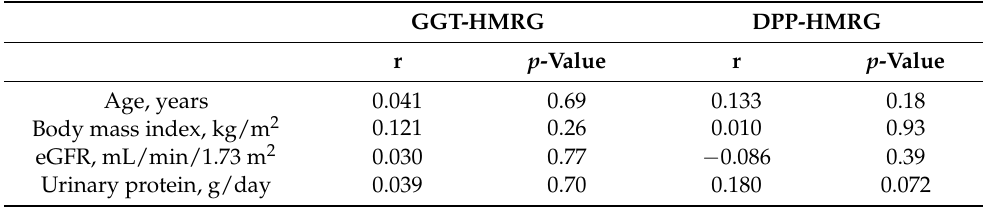
Table 2. Correlations between fluorescent intensities and clinical parameters.